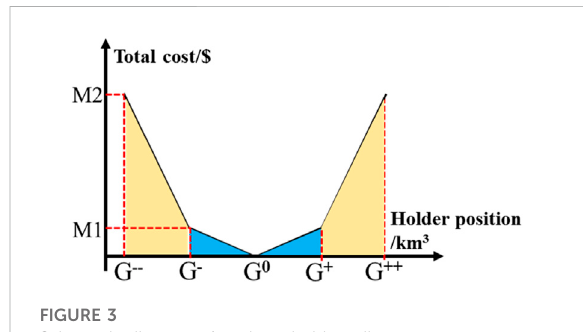
FIGURE 3 Schematic diagram of coal gas holder adjustment cost.